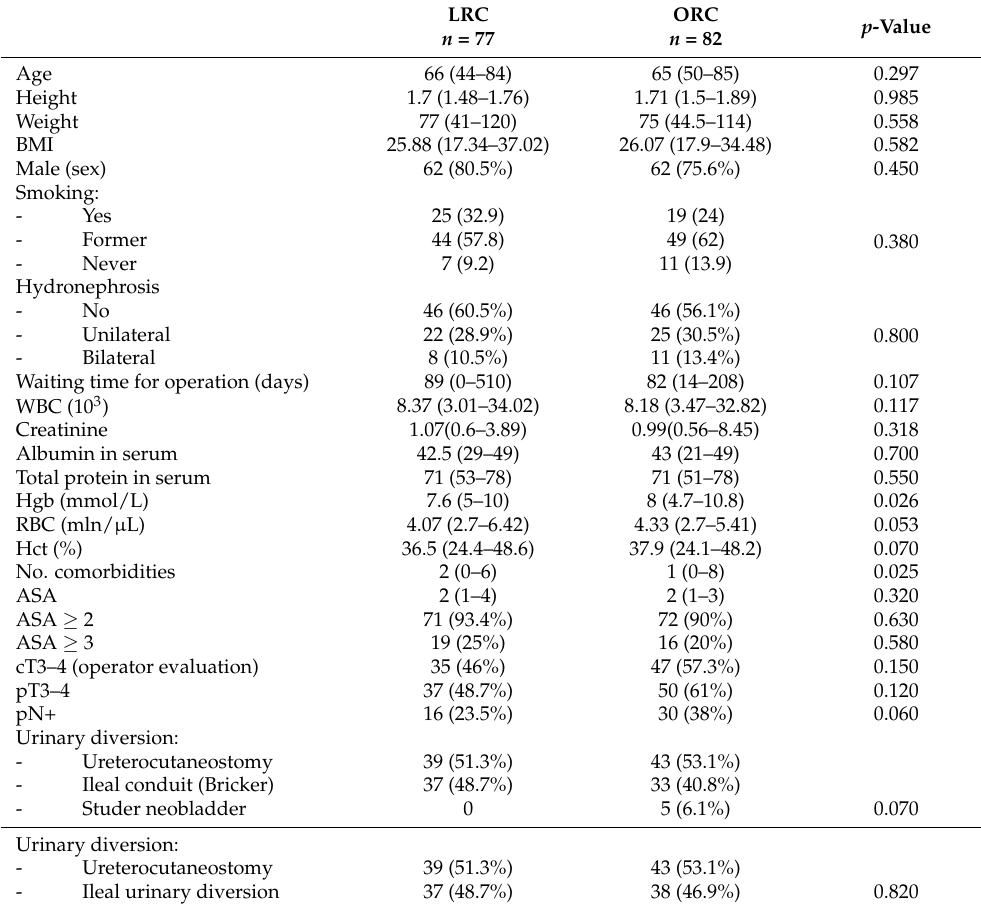
Table 1. Comparison of the study and control group.